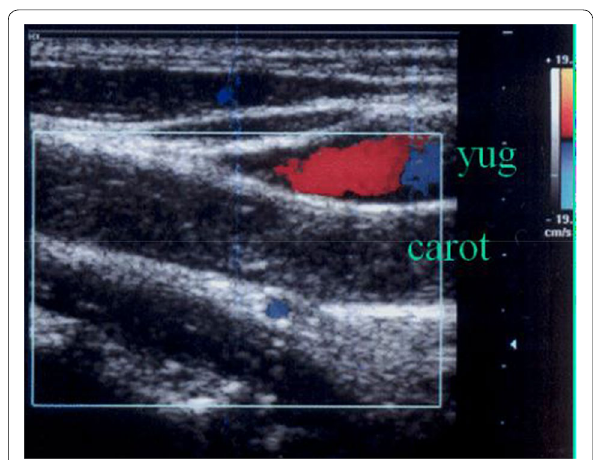
Fig. 12 Complete post traumatic carotid artery thrombosis. Longi- tudinal view of the neck shows abscence of flow in the carotid artery (carot). The jugular vein is partially visualized (in red and blue )